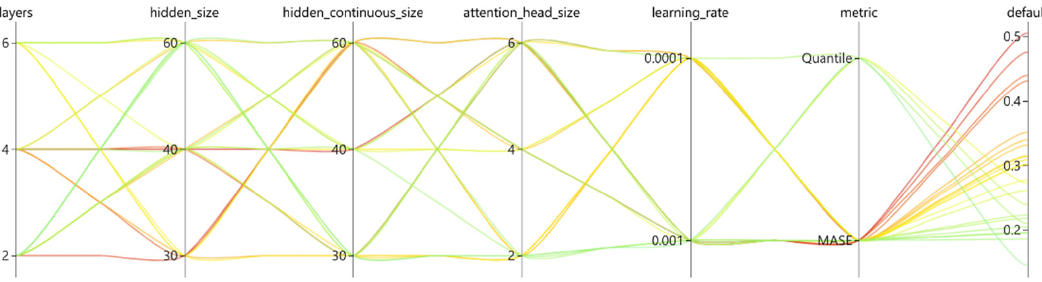
Figure 9. Results during the tuning of the hyperparameters for TFT with NNI.